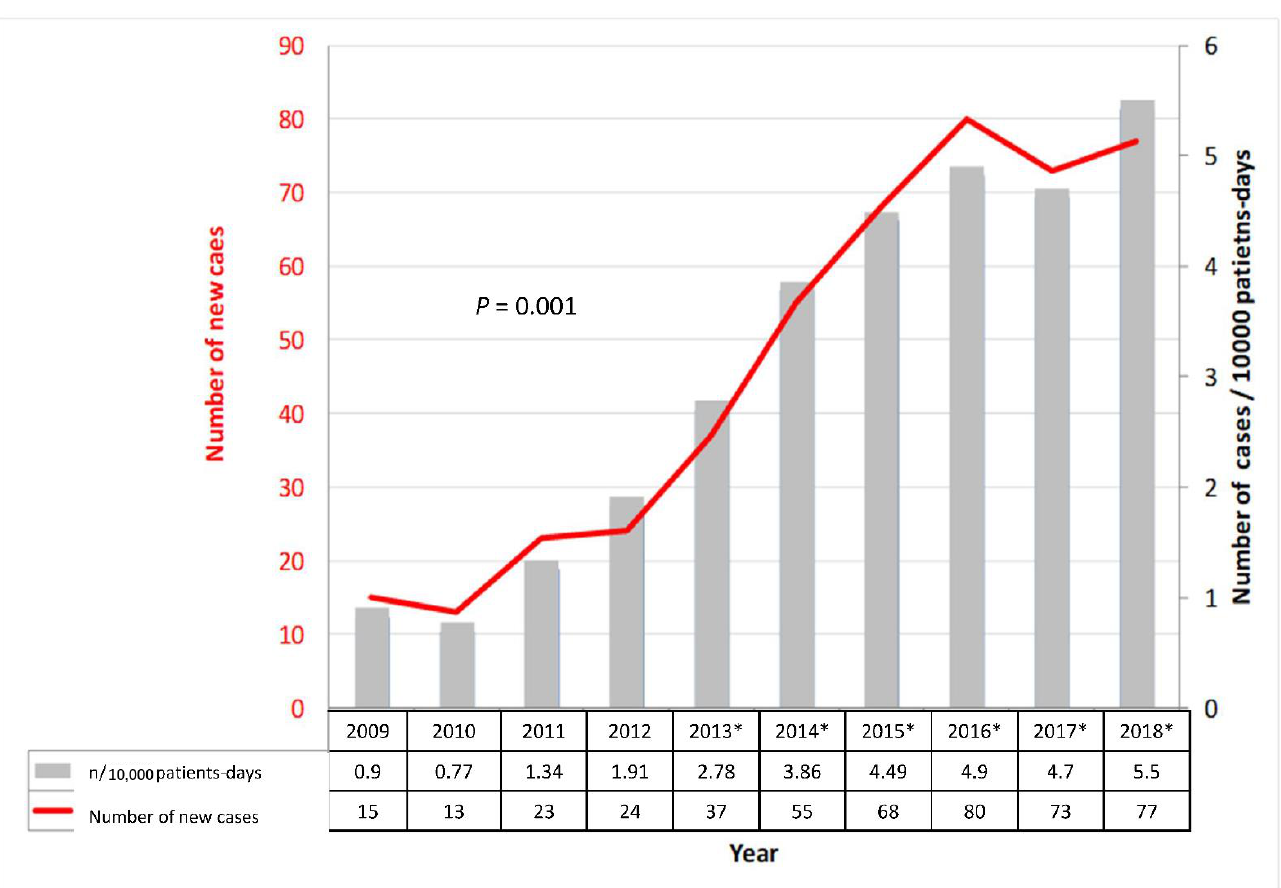
Figure 1. Trends in the number of new cases and incidence density of CDI (2009 – 2018). * PCR was added as the second step in the two-step screening